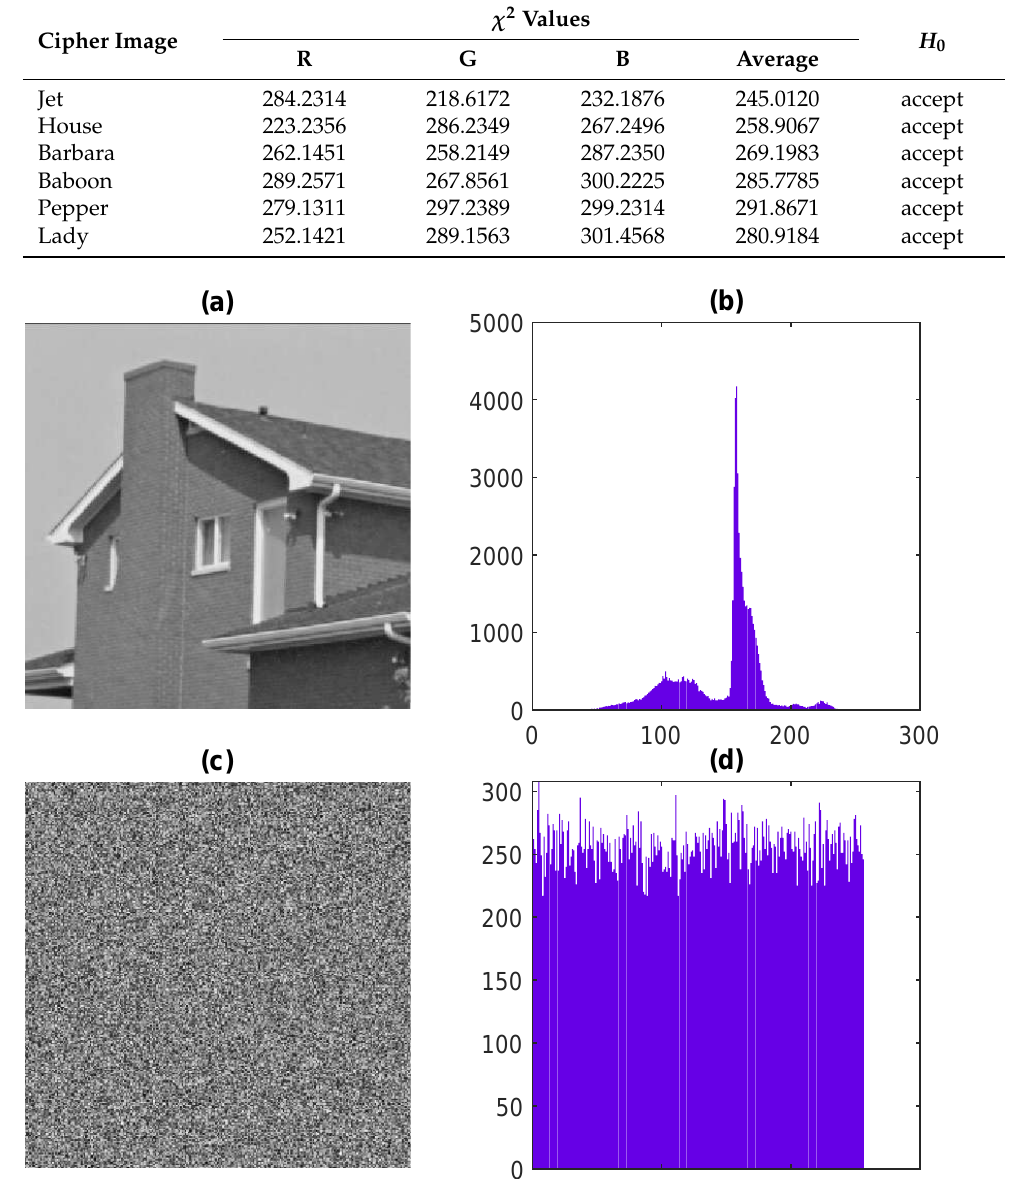
Table 1. χ 2 -values of the scheme.